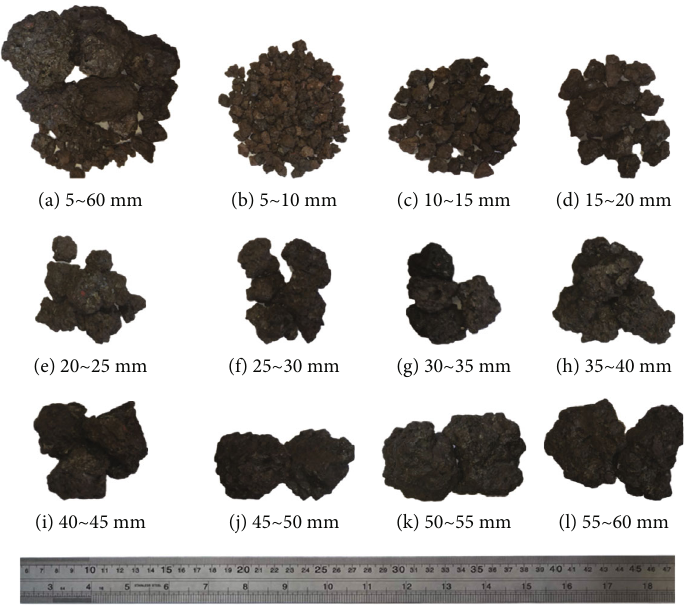
Figure 3: Photographs taken on the sinter of 5 ~ 60mm: (a) the unsorted sinter mixture with the multisize; (b – l) 11 kinds of the sieved sinter with the monosize. Table 1: Expressions of the measured and calculated method for characteristic parameters of sinter particles. Characteristic parameter Expression Equation Apparent density of the monosize sinter [17, 18]